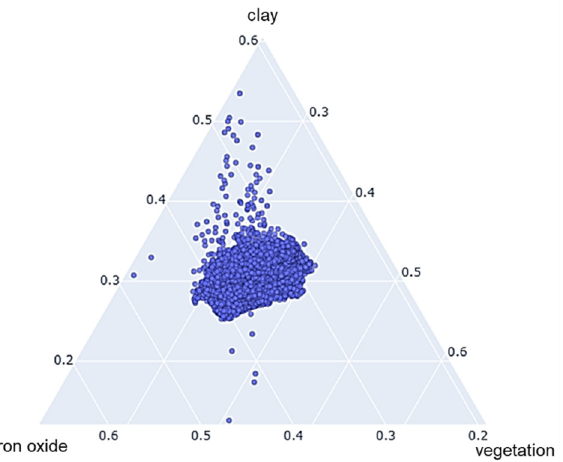
Figure 6. Polygon spectra of “IRG” units on ternary plot. Spectra from Abrams ratio image with 3 bands representing clay, iron oxide, and vegetation.